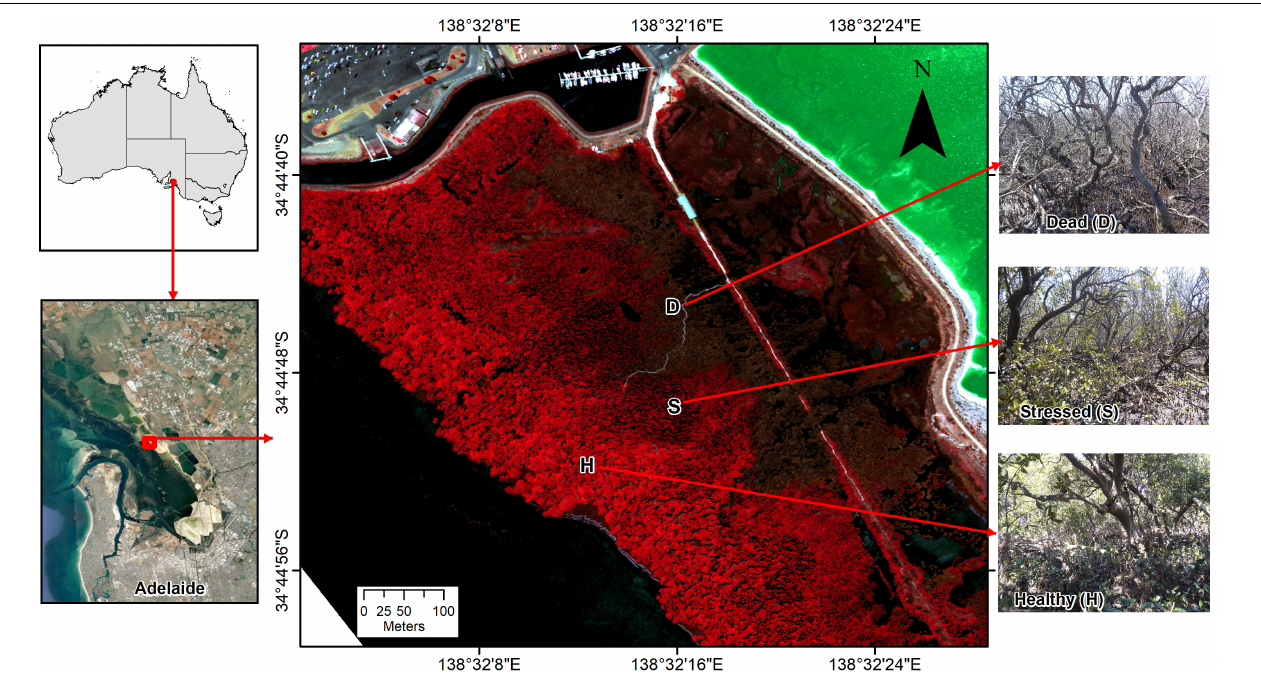
FIGURE 1 | Location of studied temperate mangrove forest near St Kilda, Gulf St. Vincent, South Australia, with sampling locations across zones from “healthy” (H, near seaward edge) to “dead” mangrove (D, near former sea wall), with a “stressed” (S) zone in between. The underlying Color-Infrared (CIR) image from January 2021 shows healthy vegetation in bright red, dead foliage in brown and the hypersaline salt pond inland from the mangrove and saltmarsh in bright green.